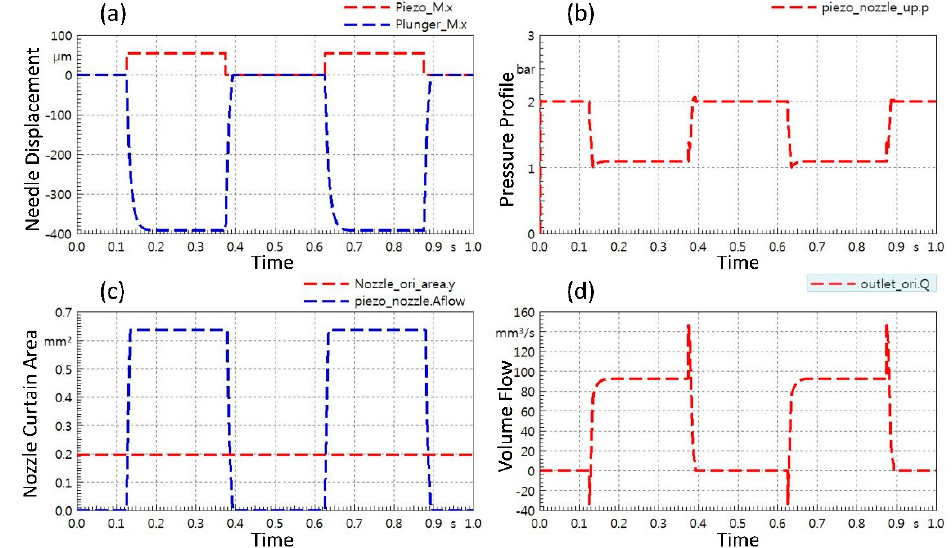
Figure 4. Simulation results for jet dispenser: ( a ) Plot of piezostack displacement and needle displacement; ( b ) pressure fluctuation with respect to tappet movement; ( c ) nozzle curtain area with reference of nozzle cross sectional area; ( d ) liquid volume flow through nozzle with respect to needle